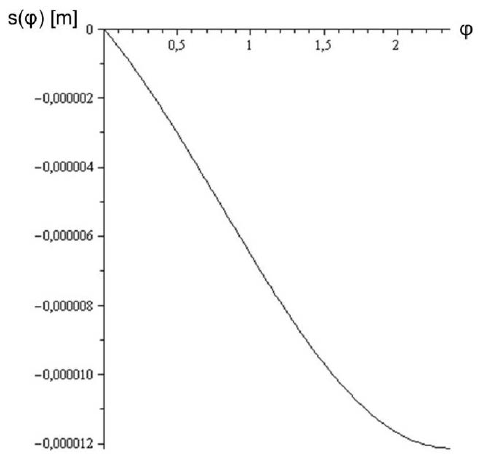
Figure 18: Plots of the slip function for Example 2.